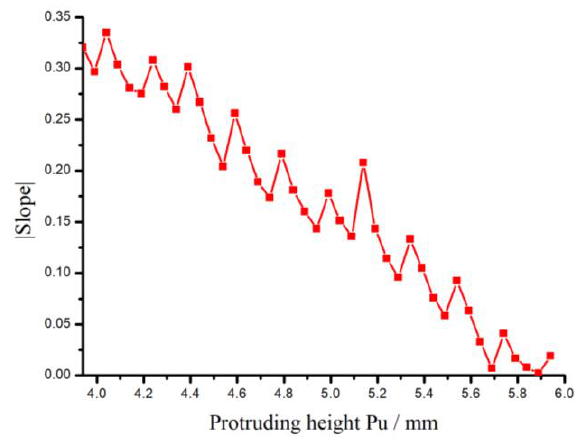
Figure 10. The interference distribution conditions.